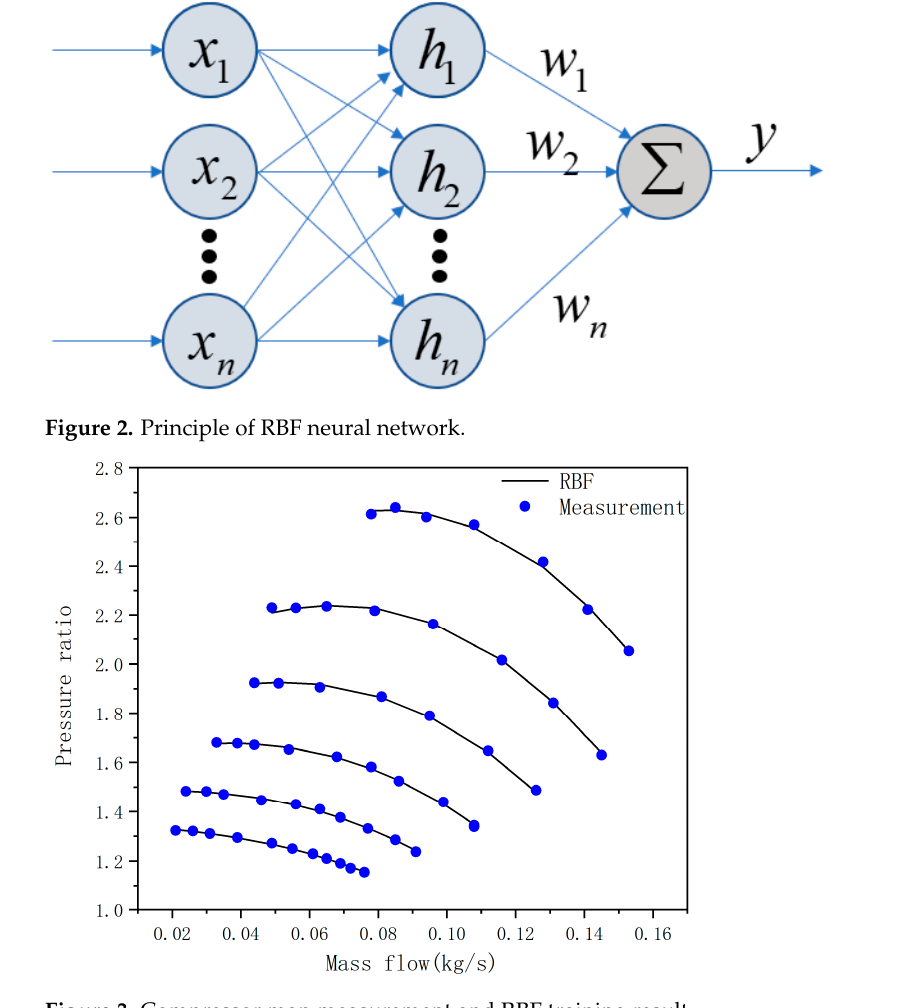
Figure 3. Compressor map measurement and RBF training result.